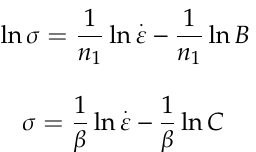
Figure 13. The relation between σ and ln ε  for five temperatures at the strain of 0.3. Then, the expression of F ( σ ) for all σ (Equation (17)) can be substituted into Equation (16), which gives the equation below.